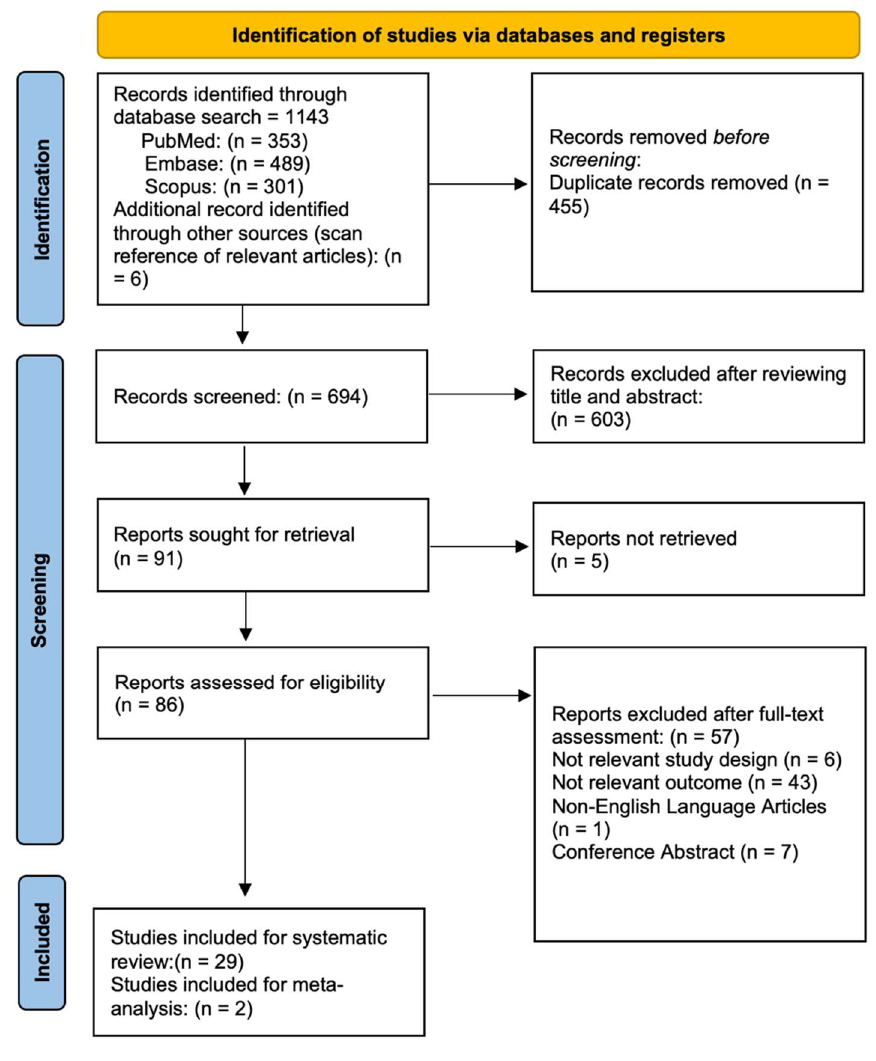
Figure 1. Flow diagram of the study selection process.